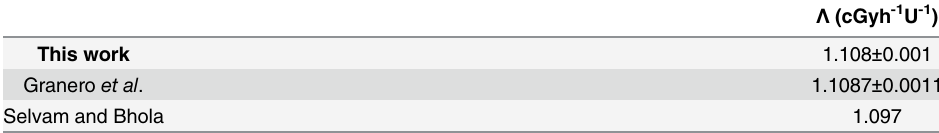
Table 1. Dose Rate Constant of the BEBIG 60 Co